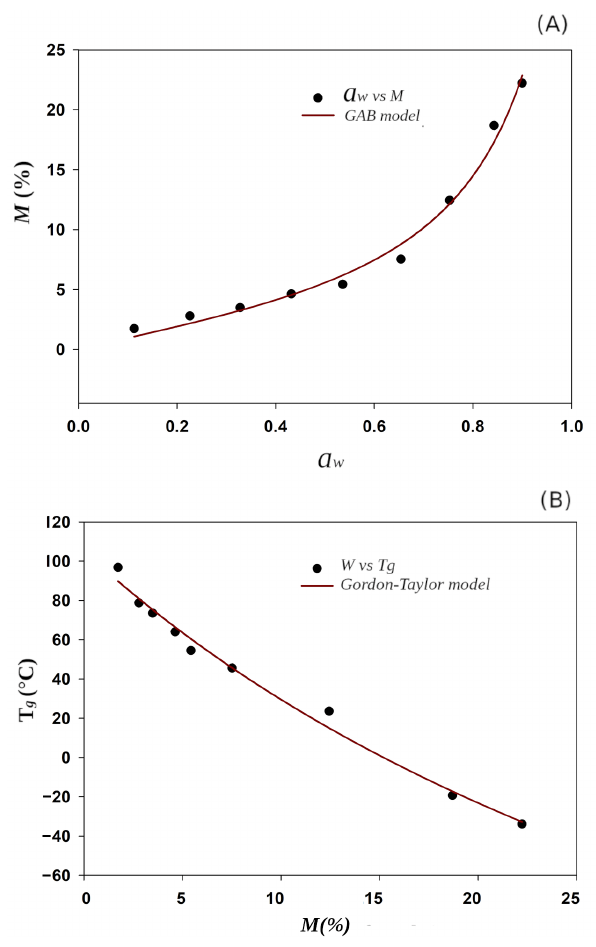
Figure 6. Predicted models for avocado oil microcapsules: ( A ) GAB model (—) sorption isotherm and M ( • ) in function of a w ; ( B ) Gordon–Taylor model (—) and experimental data of T g ( • ) in function of moisture content M